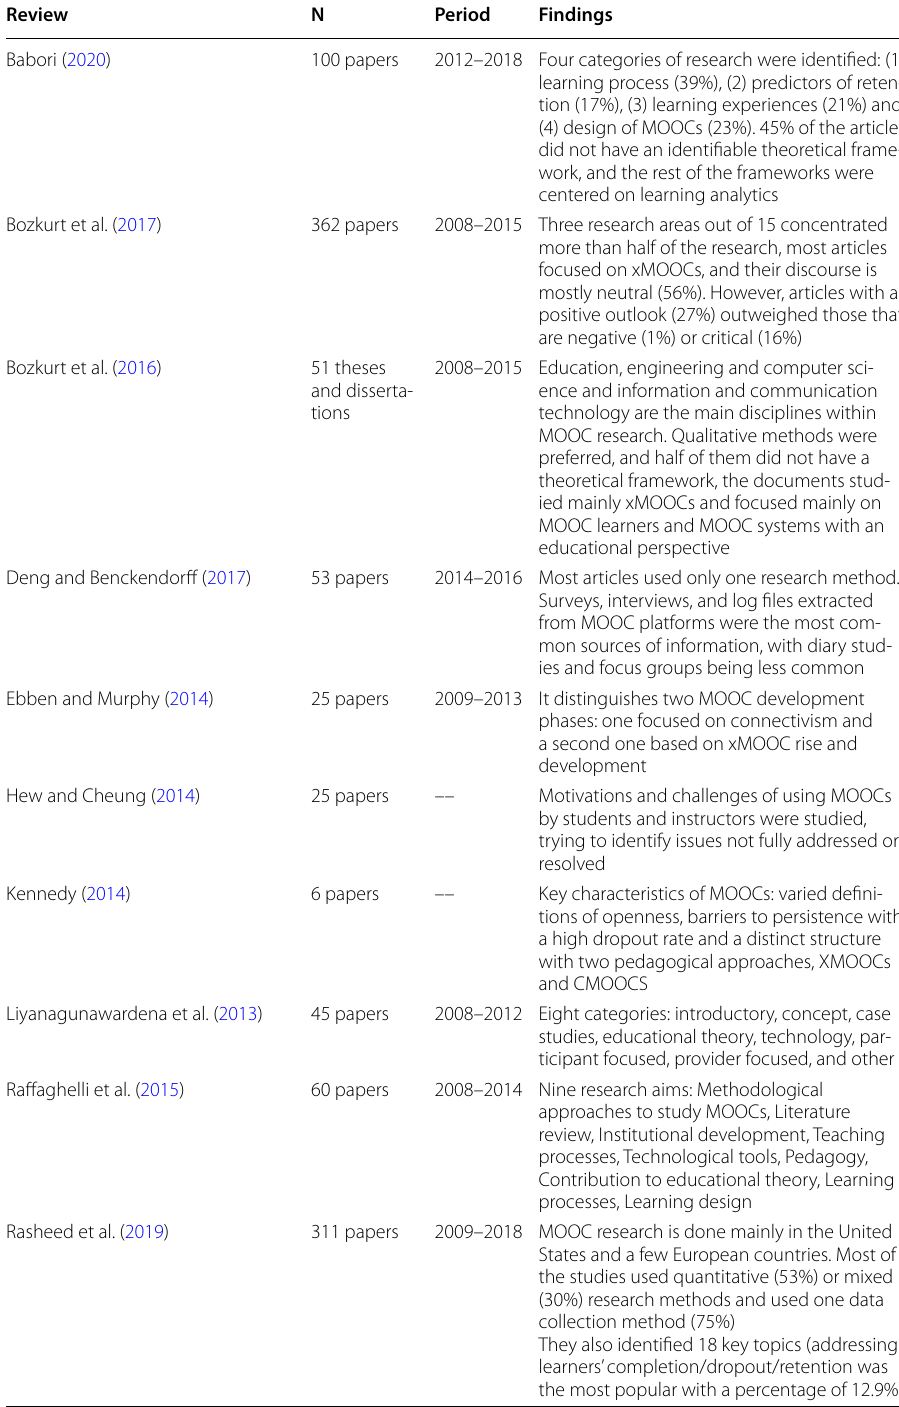
Table 1 Synthesis of literature reviews on MOOC